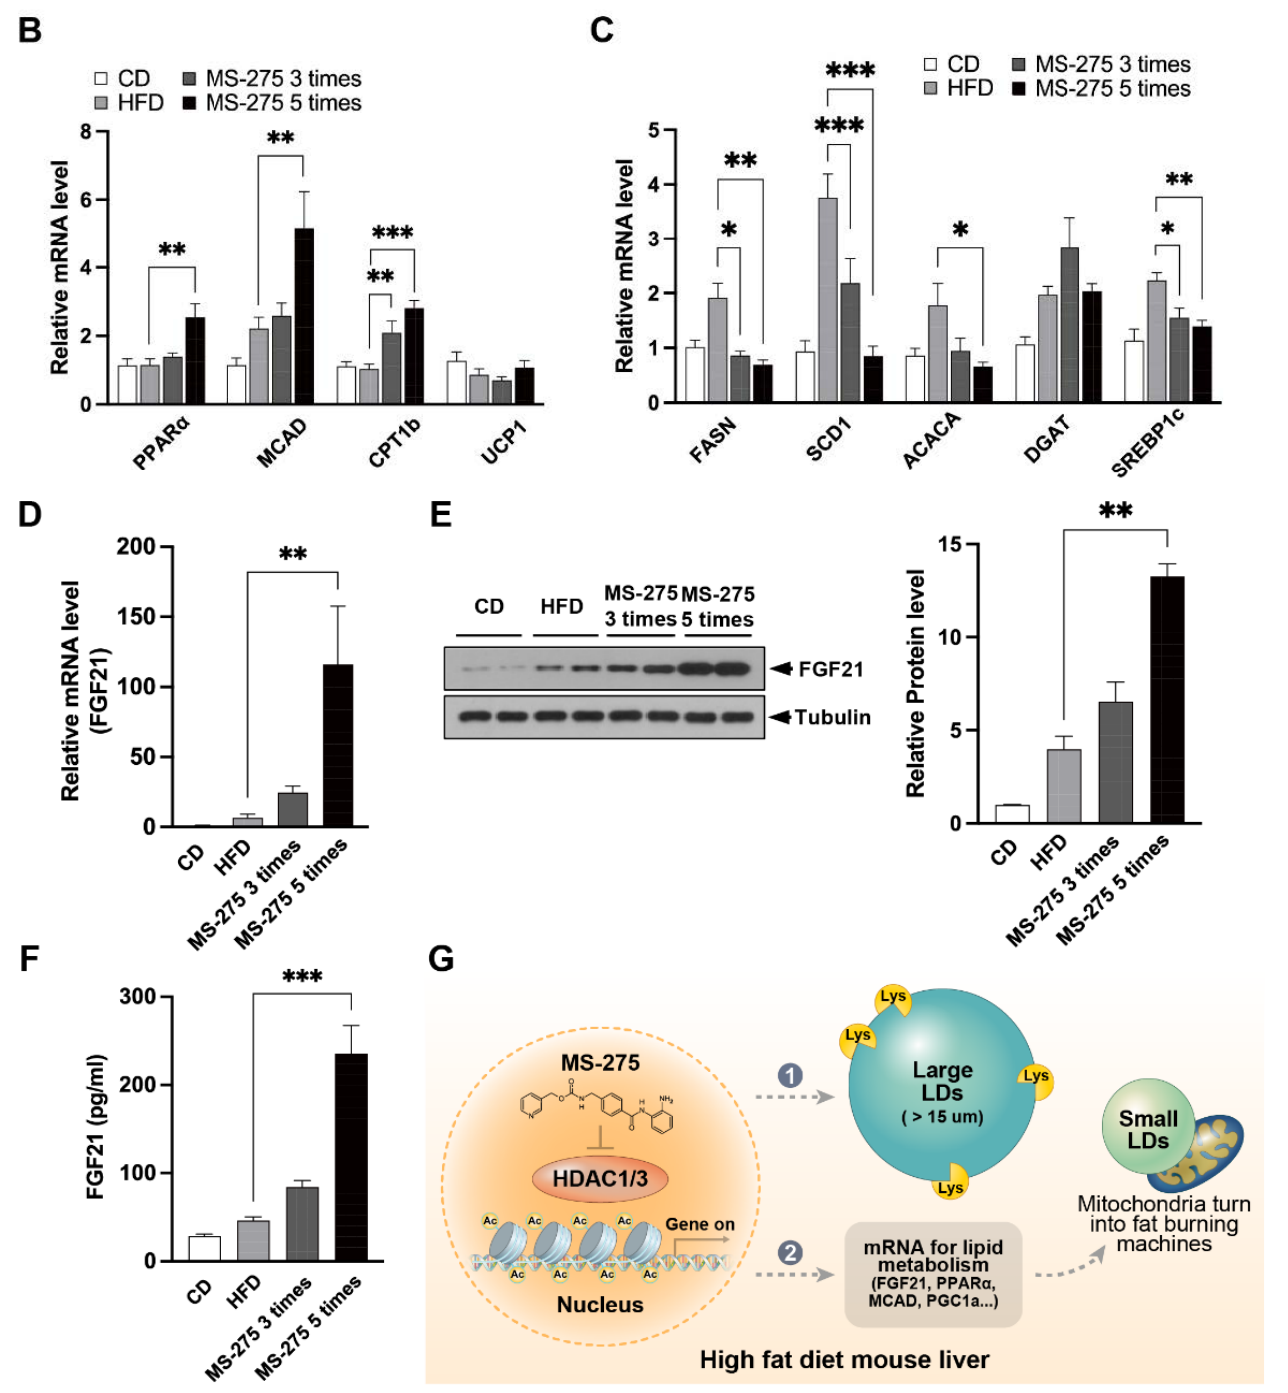
Figure 6. MS-275 increased mitochondrial oxidation in mouse primary hepatocytes, and the expression of FGF21 in HFD-induced fatty liver. ( A ) Mouse primary hepatocytes were isolated from 8-week-old C57BL/6J mice. Mitochondrial respiration in mouse primary hepatocytes exposed to 1 or 3 µM MS-275 was investigated by measuring the mitochondrial oxygen consumption rate (OCR); ( B , C ) mRNA expression levels of FAO-related genes (PPAR α , Acadm, Cpt1b, and Ucp1) and lipid synthesis-related genes (Fasn, Dgat, Scd, Acaca, Srebp1c) in liver tissue injected with MS-275 were determined by qRT-PCR; ( D ) Expression of FGF21 was determined by qRT-PCR; ( E ) FGF21 levels in liver tissue injected with MS-275, as determined by immunoblotting; ( F ) Plasma levels of FGF21 measured using an FGF21 assay kit; ( G ) Mechanism of HDAC1/3 inhibition of HFD-induced steatotic liver. * p < 0.05, ** p < 0.01, *** p < 0.001 (one-way